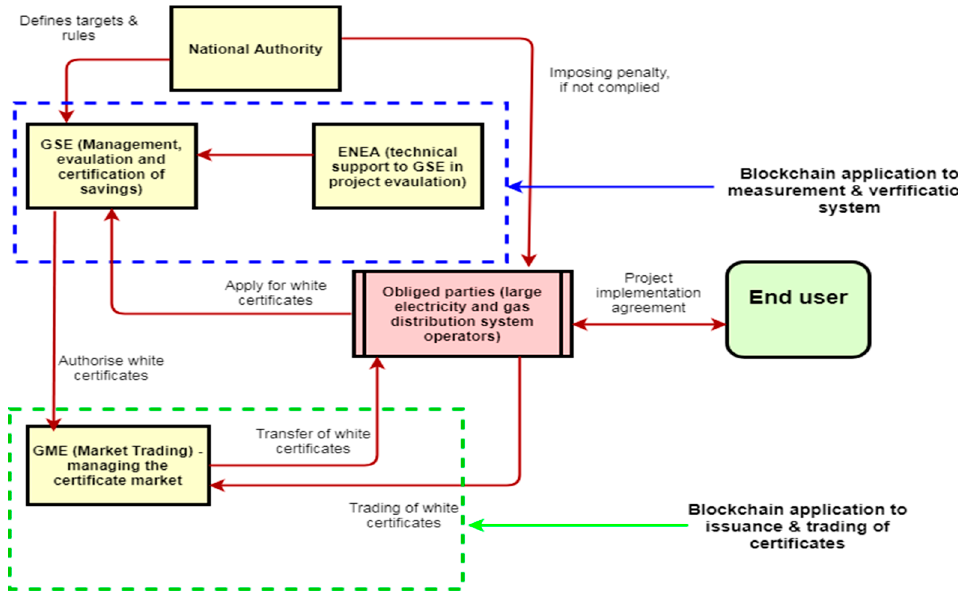
Figure 4. Key stakeholder and processes in Italian White Certificate Scheme [33,35].